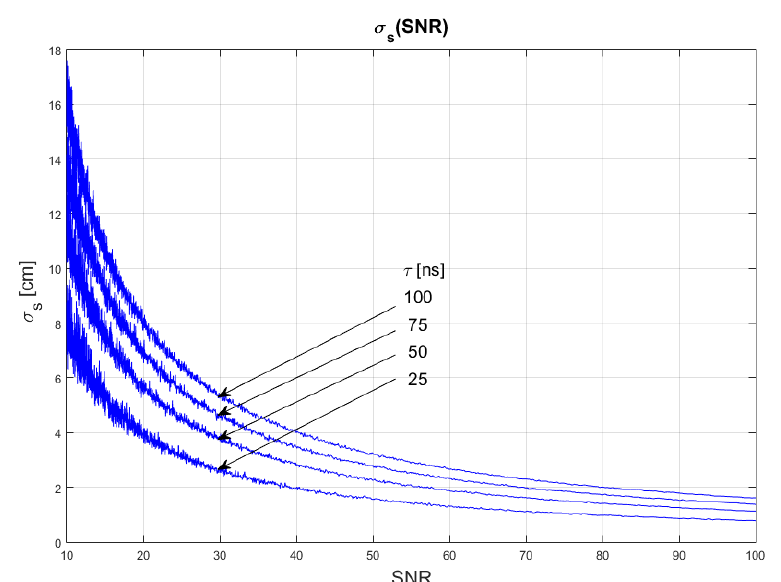
Figure 4. Dependence of measurement uncertainty on the signal-to-noise ratio (SNR). Parameters of generated pulses are shown in Table 1 Block 1.